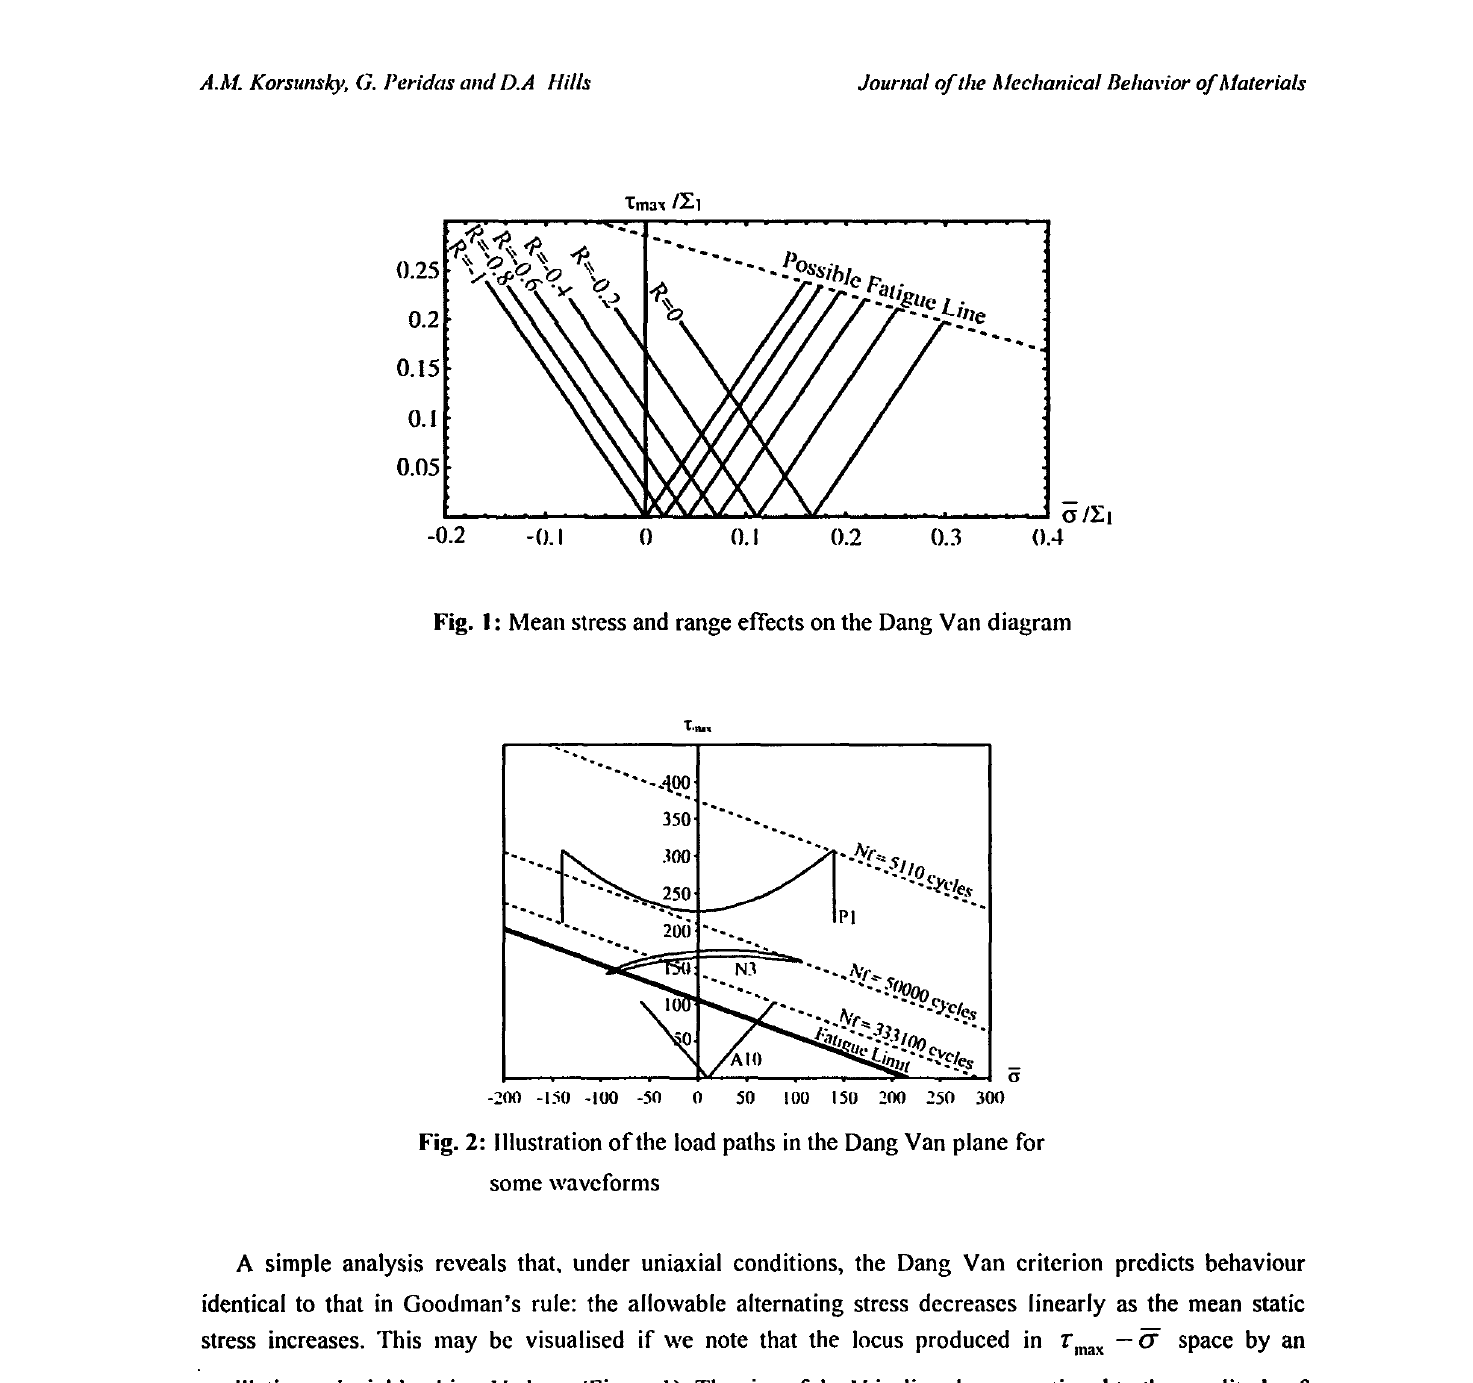
Fig. 2: Illustration of the load paths in the Dang Van plane for some